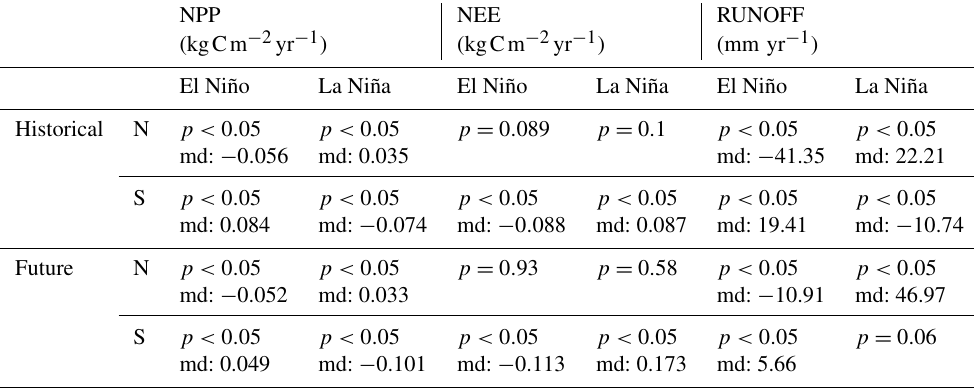
Table 1. Paired t test results to test whether there is a significant difference in the vegetation simulations that are driven with and without ENSO contributions for the three strongest ENSO events during the historical period (1951–2005) and with and without intensified ENSO signal for the strongest ENSO events during the future period (2006–2100). Italics indicate insignificant differences according to the p = 0 . 05 threshold. Significant p values indicate rejection of the H 0 in favour of the alternative; that is, the true difference in means is not equal to 0. NPP NEE RUNOFF (kgCm − 2 yr − 1 ) (kgCm − 2 yr − 1 ) (mm yr − 1 ) El Niño La Niña El Niño La Niña El Niño